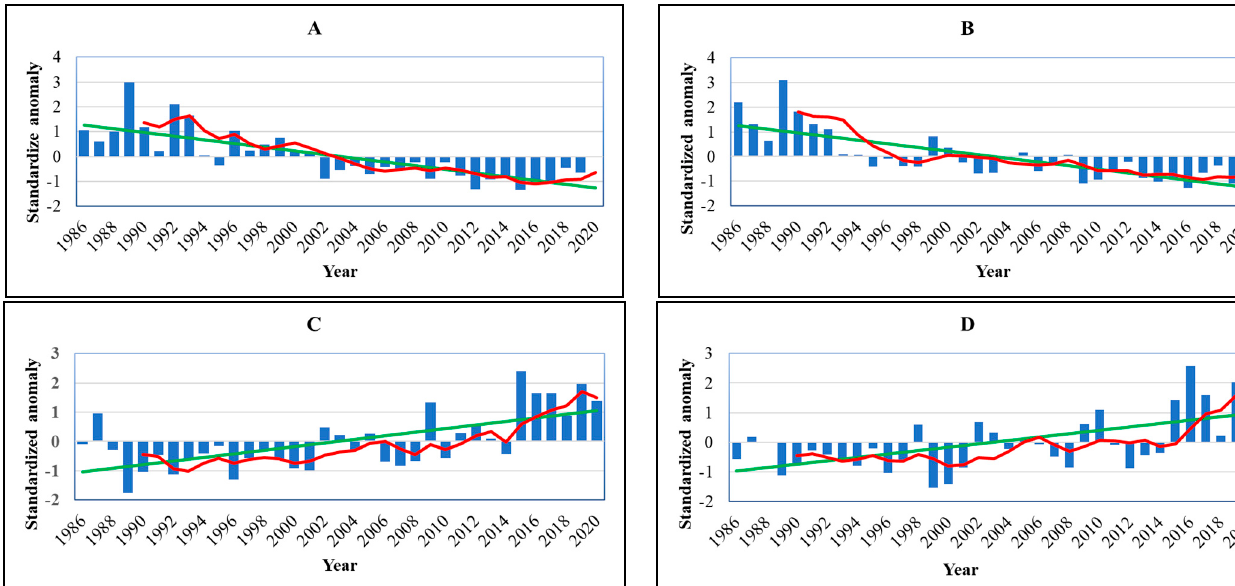
Figure 10. The mean country-wide extreme temperature indices in the period between 1986 and 2020: ( A ) TX10p, ( B ) TN10p, ( C ) TX90p, and ( D ) TN90p. Note: The straight green line is the linear trend for the variables, while the red curved line is the five-year moving average.